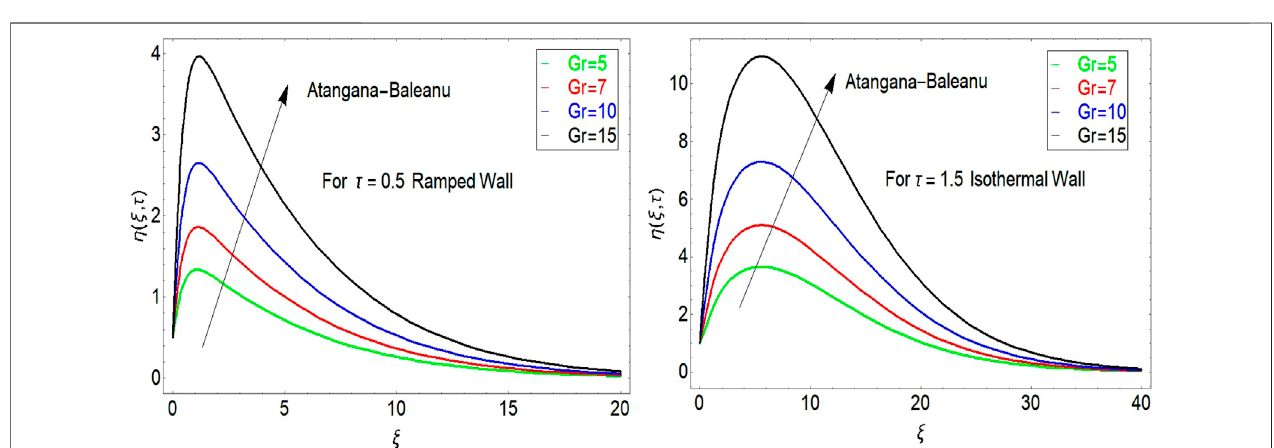
FIGURE 2 | In fl uence of Gr on velocity for constant and ramped temperature.